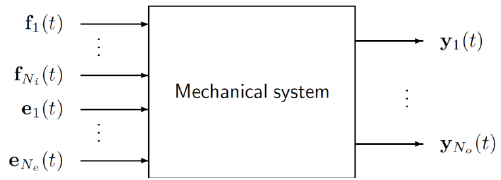
Fig. 1. Responses ( ( ) t y ) of a mechanical system due to measured ( ( ) t f ) and unmeasured ( ( ) t e )